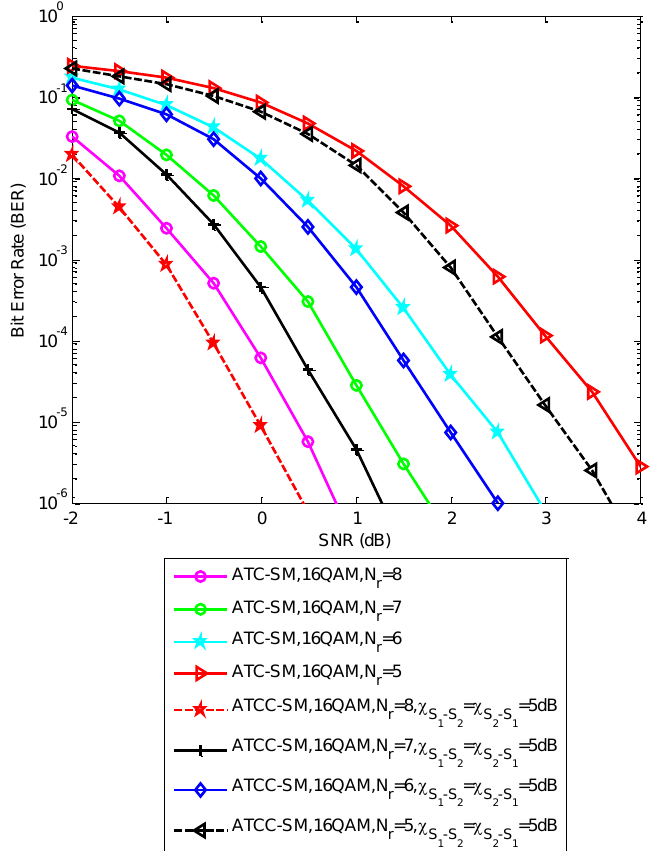
Figure 9. Bit error rate (BER) performance of the two-source ATCC-SM scheme under a non-ideal inter-user channel scenario and ATC-SM based on the CMI over the slow Rayleigh fading channel, K = 1024, 16QAM, N t = 8 and different numbers of receive antennas.